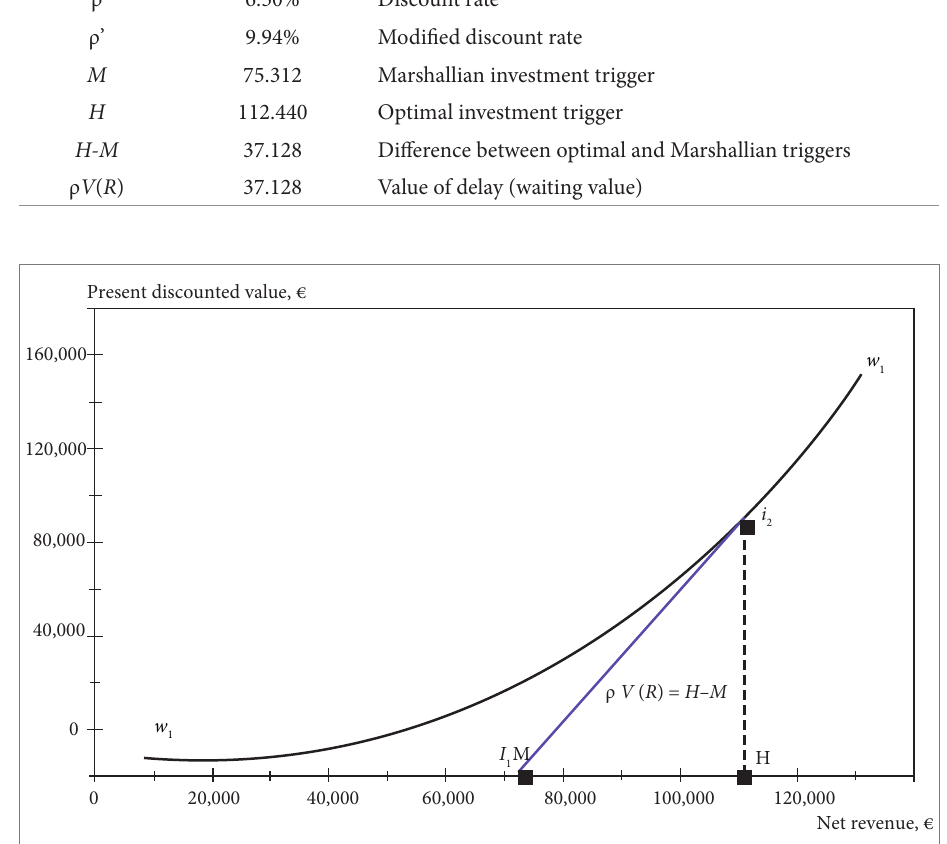
Fig. 3. Value of delay (waiting